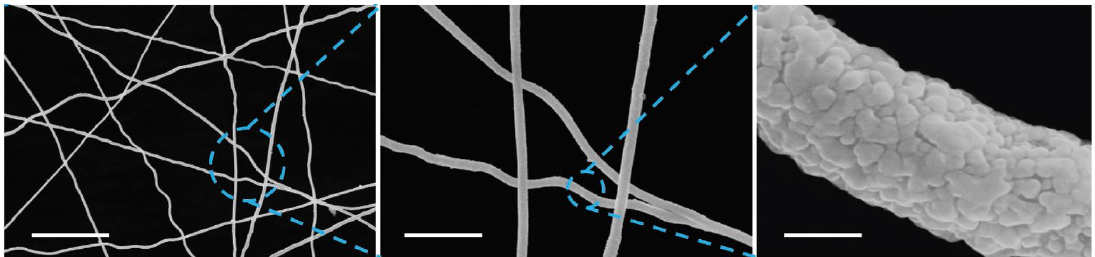
Figure 16. SEM image of AgNW network (scale bar 10 and 2 µm and 300 nm) [87].